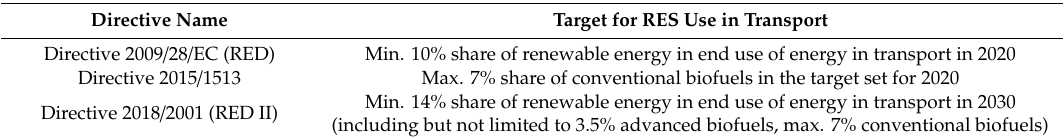
Table 1. Specification of the most important obligations resulting from the directives in the scope of use of renewable energy sources (RES) in transport for member states of the European